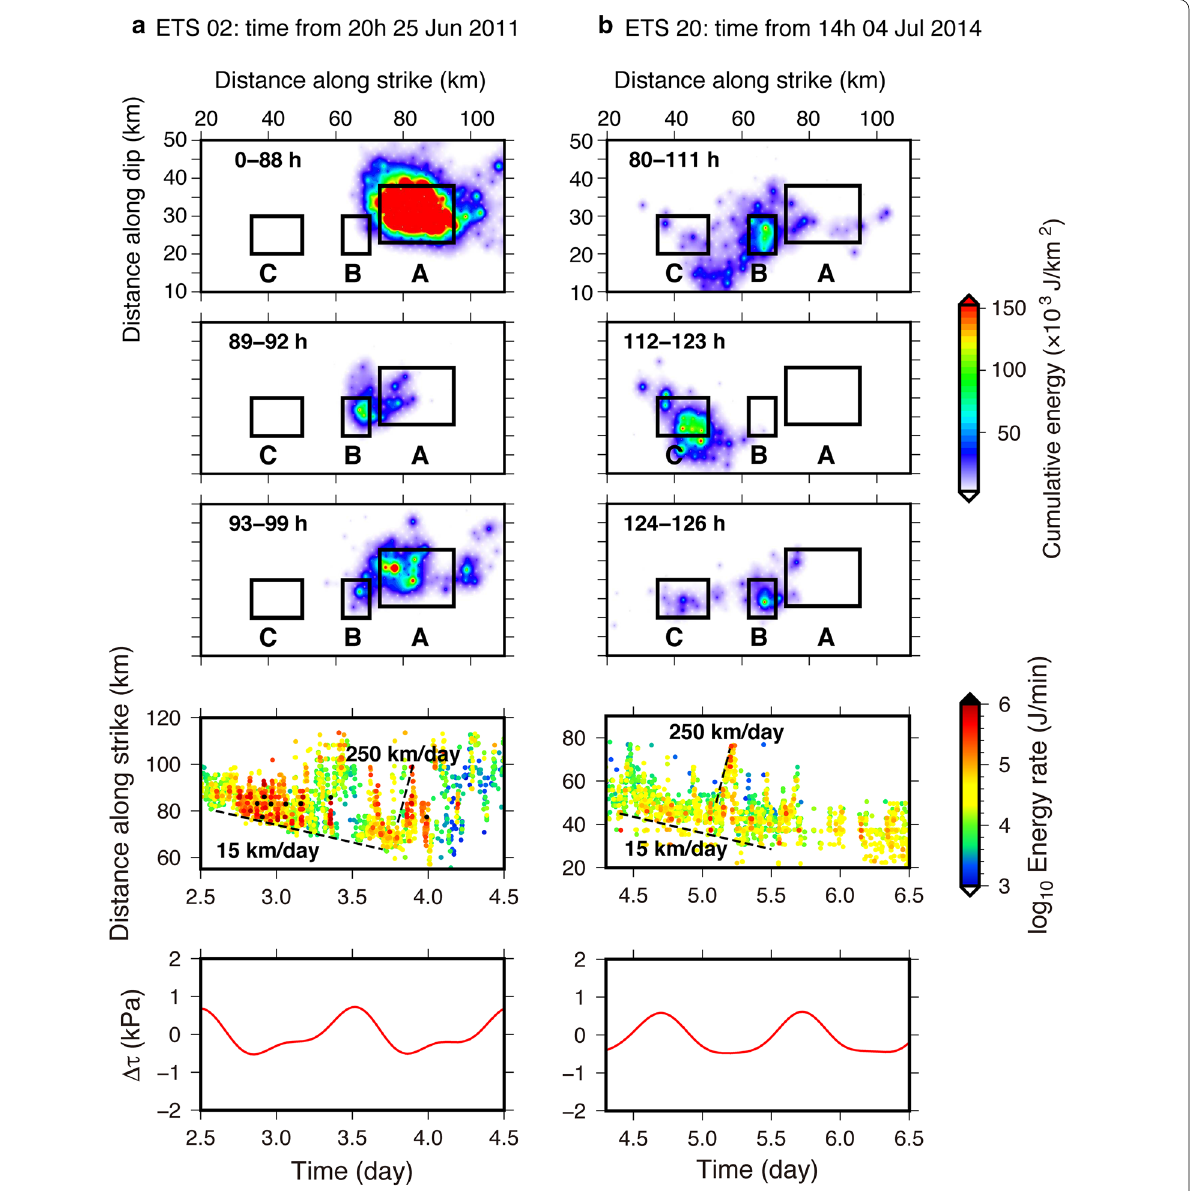
Fig. 7 Evolution of RTRs during a ETS 2 and b ETS 20. The top three panels show the cumulative seismic energy release during the period of each snapshot (upper left corner). Black rectangles show the locations of high-energy patches on the subducting Philippine Sea plate interface. The second plot from the bottom shows the spatio-temporal distribution of tremor hypocenters, with colors corresponding to radiated energy rate and dotted lines indicating migration speeds. The bottom plot shows the tidal shear stress at a depth of 35 km on a fault plane (with strike, dip, and rake taken from corresponding short-term SSEs listed in Table 3) below patch B for ETS 2 and below patch C for ETS 20. Positive shear stress promotes slip on a